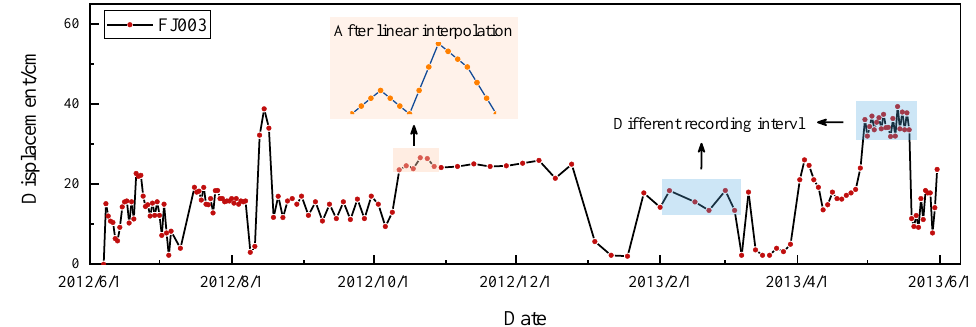
Figure 6. Data recording interval and linear interpolation representation of the displacement data of the Huanglianshu